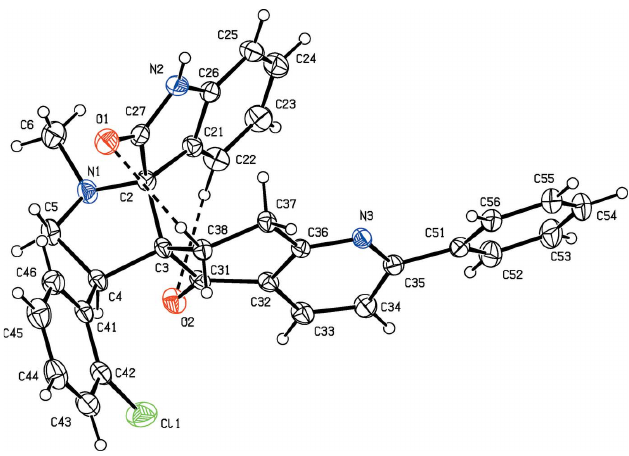
Figure 1 The molecular structure of the title compound, showing 30% probability displacement ellipsoids and atom labelling. The intramolecular C— H (cid:3)(cid:3)(cid:3) O contacts (see Table 1) are shown as dashed lines.